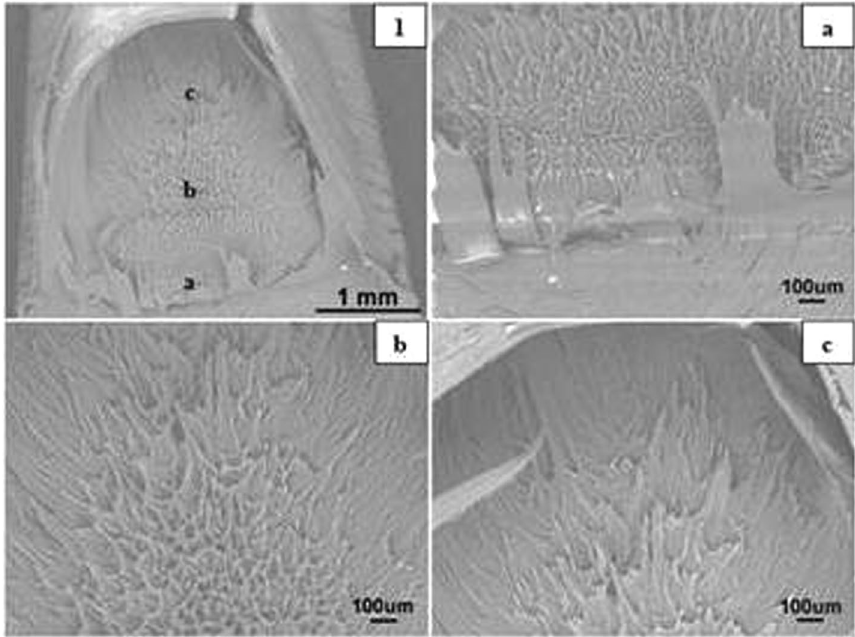
Figure 12. SEM images of blunt notched HDPE fracture surfaces at 0.50 mm/min (1) notch at the bottom, crack propagating from bottom to top at 25